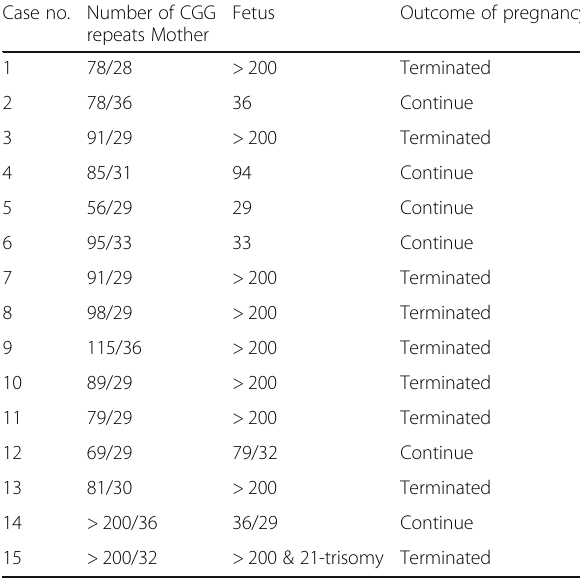
Table 3 Results of prenatal diagnosis in pregnant mothers of pre-mutation and full mutation carriers Case no. Number of CGG repeats Mother